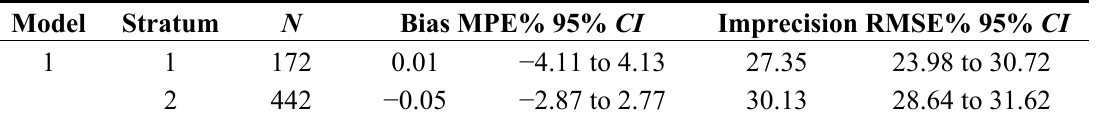
Table 5. Predictive performance of the allometric model in the validation